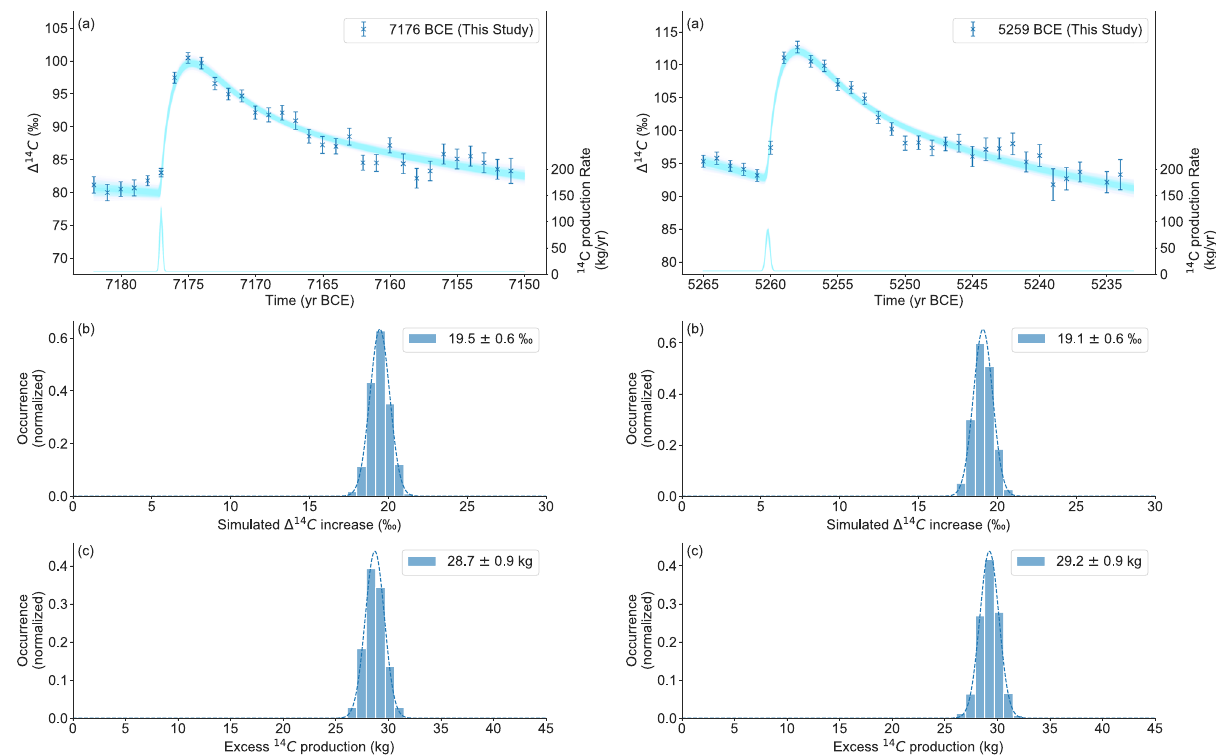
Fig. 2 Evaluation procedure of the found events. a Mean data of the two events (7176 BCE left, 5259 BCE right) with 1- σ errors and result of 1000 Simulations (blue lines) The fi tted Gaussian shaped production spikes for all simulations is also shown. b Distribution of the simulated Δ 14 C increases (blue bars) with a gaussian fi t (dashed line). c Distribution of excess 14 C production (blue bars) with Gaussian fi t (dashed